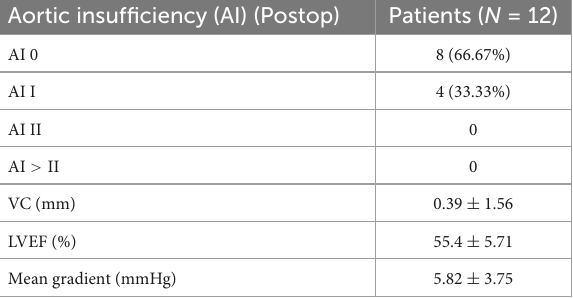
TABLE 3 Grading of the aortic valve insufficiency after the reimplantation of the aortic valve. Aortic insufficiency (AI) (Postop) Patients ( N =